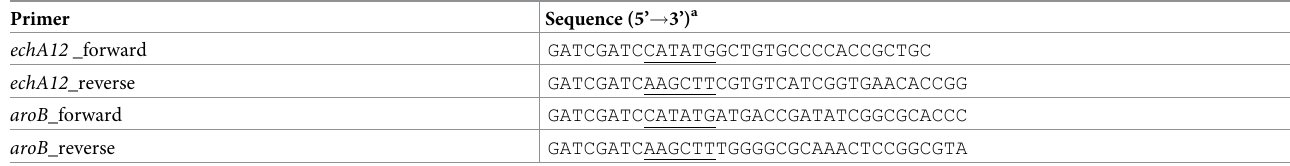
Table 1. Primers used for the construction of pVV16- echA12 and pVV16- aroB .